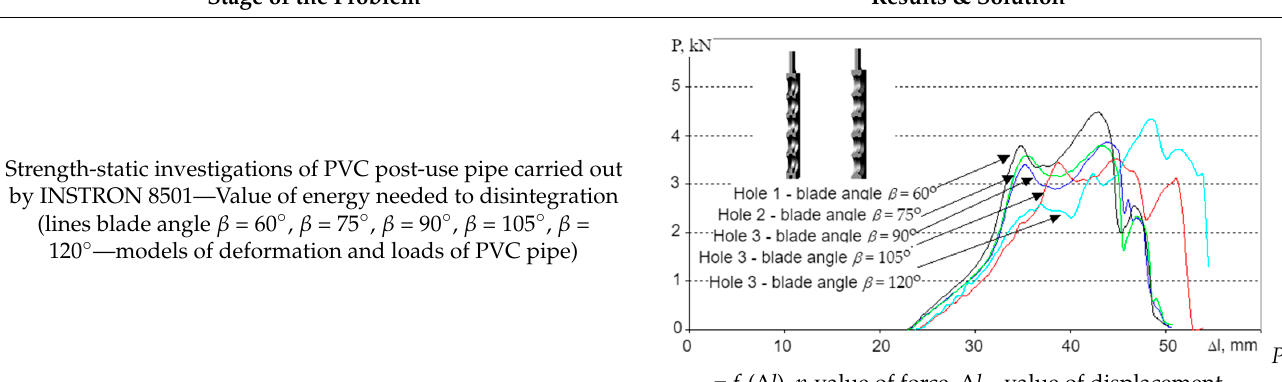
Table 4. The investigations on quasi-static strength terms presented in [133]. Results &